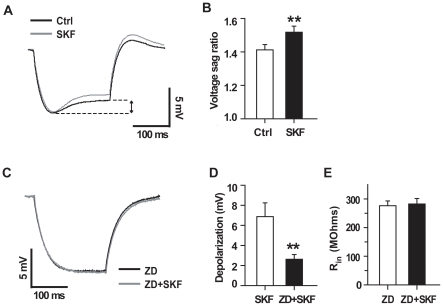
Effects of SKF83959 on subthreshold response of CA1 pyramidal neurons.A. Superimposed responses to prolonged hyperpolarizing current pulses (400 ms, −50 pA) recorded from a representative neuron before (black) and during (gray) the perfusion with SKF83959 (50 µM), showing the enhanced voltage sag (arrow). The resting potential of the neuron was −60 mV, and the membrane potential was manually clamped to compensate the SKF83959-induced depolarizing response. B. Bar graphs showing the voltage sag ratios in the presence and absence of SKF83959 (50 µM). The voltage sag ratio was quantified as the peak voltage deflection divided by the steady-state voltage deflection. C. The results were obtained from another neuron in the presence of ZD7288 (10 µM). The resting potential of the neuron was −66 mV. Note that ZD7288 completely abolished the voltage sag. D. Bar graphs showing the maximal depolarizing response caused by SKF83959 (50 µM) in the presence (n = 6) and absence (n = 8) of ZD7288 (10 µM). E. Bar graphs showing the input resistance of CA1 pyramidal neurons measured in the presence of ZD7288 (10 µM) or in the presence of ZD7288 (10 µM) and SKF83959 (50 µM). n = 8 for each group. ** P<0.01. Ctrl, Control; SKF, SKF83959; ZD, ZD7288.